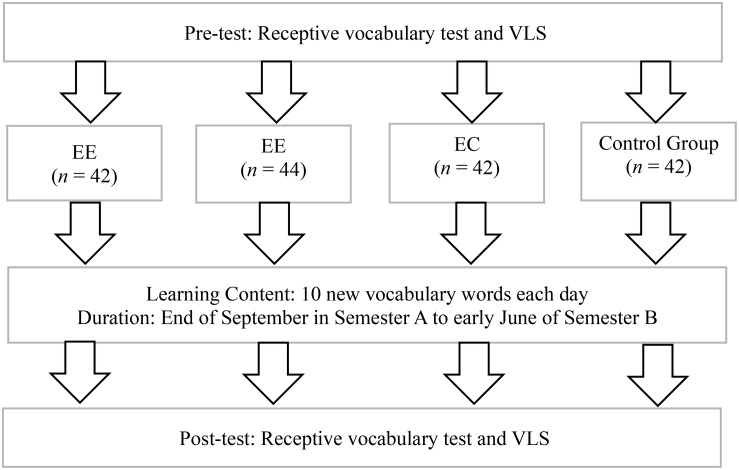
Research design.